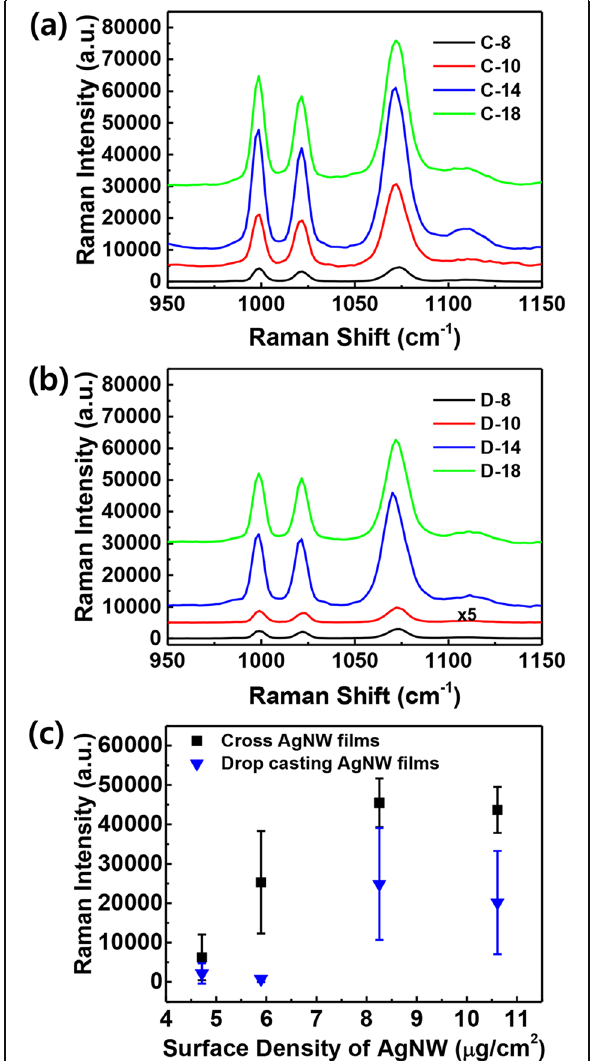
Fig. 4 Raman spectra of benzenethiol on a the cross-AgNW films and b the drop-casted AgNW films coated on the Au surface. c Relative Raman intensities of the benzenethiol peak at 1071 cm − 1 as a function